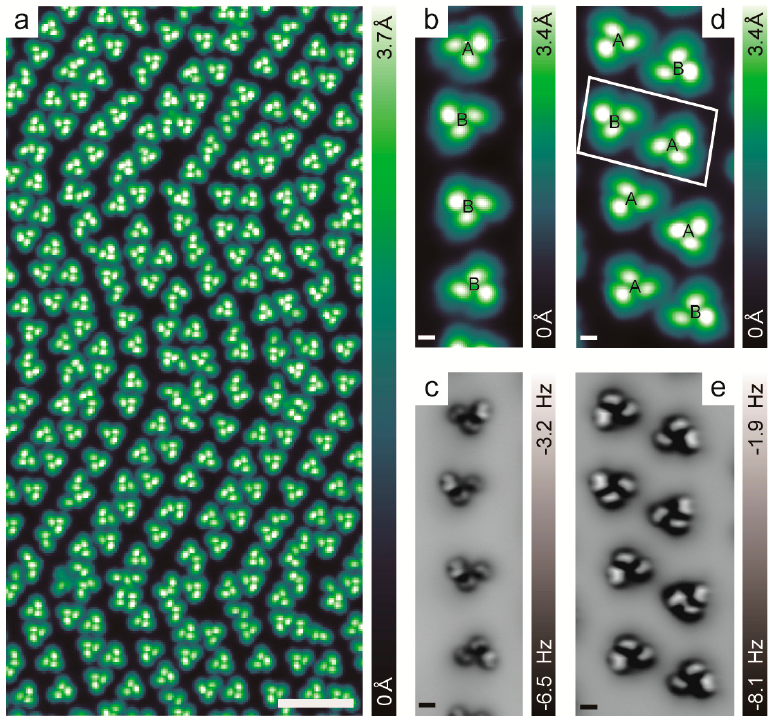
Figure 6. ( a ) Overview STM image of rac -[6]H at high coverage. (1800 mV, 10 pA). ( b , c ) STM and nc-AFM images of a typical single chain of rac -[6]H self-assembly composed of the trimers in A-B-B-B sequence. ( d , e ) STM and nc-AFM images of a typical double chain of rac -[6]H self-assembly composed of the trimer pairs in AB-BA-AA-AB sequence. One representative trimer pair BA is marked in the rectangular box. Scale bars: 5 nm ( a ), 5 Å ( b – e ).